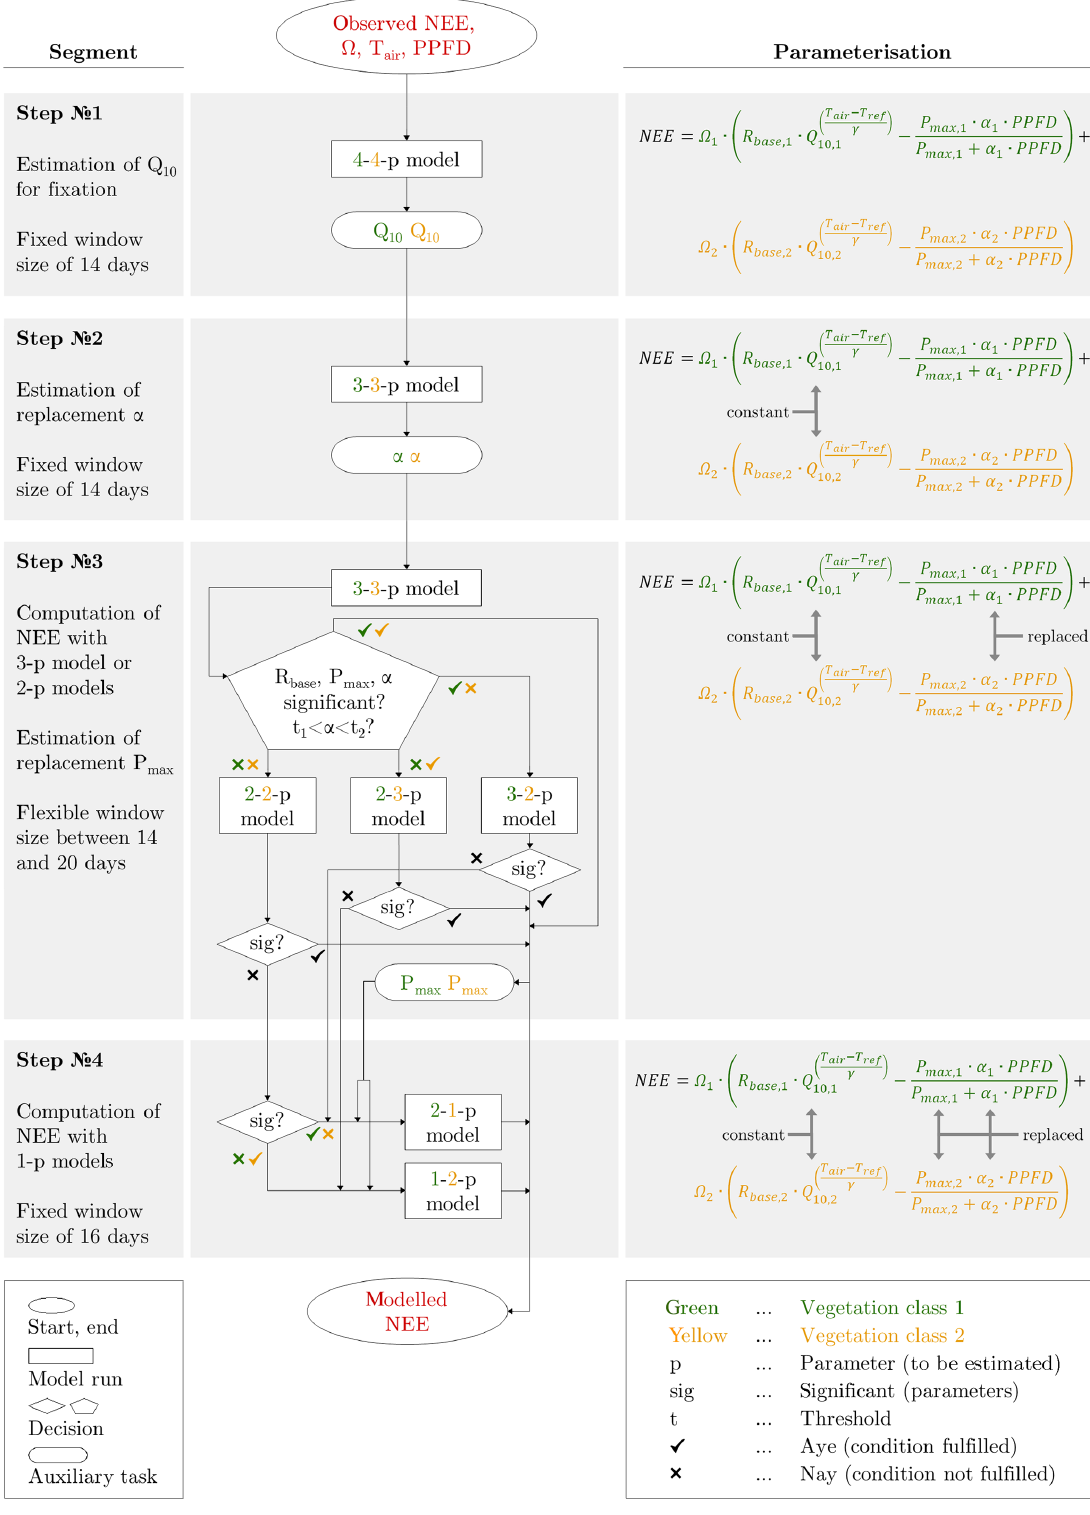
Figure 3. Schematic overview of the model calibration along four steps, in which different parameterisations were applied to obtain mean- ingful estimates for the eight fitting parameters ( R base , Q 10 , P max , α for each vegetation class). The values in the boxes (e.g. 3-2-p model) denote the number of parameters to be fitted for each vegetation